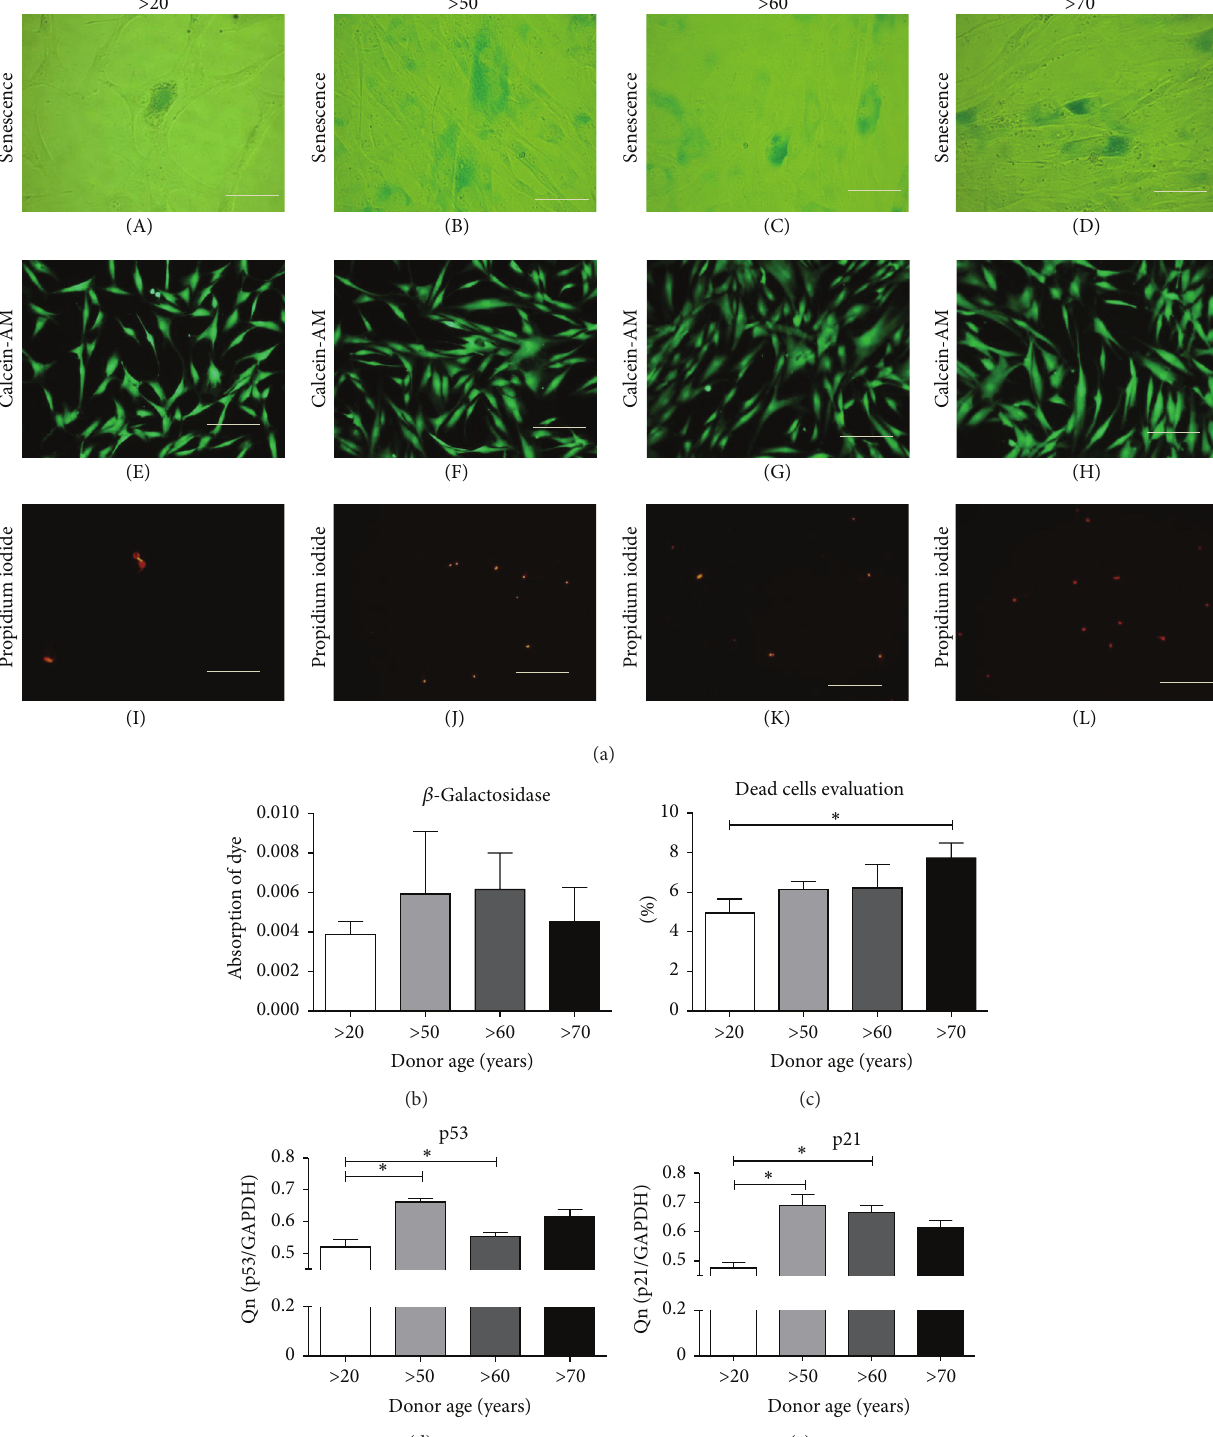
Figure 4: Characterization of age-dependent apoptosis. (a) Cells stained for senescence showing cells with 𝛽 -galactosidase accumulation (A–D), Calcein-AM (E–H), and propidium iodide (I–L) for live-dead cells identification. (b) 𝛽 -galactosidase absorbance measurement. (c) Percentage of apoptotic cells calculated from Calcein-AM/propidium iodide staining, (d) evaluation of p53, and (e) p21 on the mRNA level. Results expressed as mean ± SD. ∗ 𝑝 value <